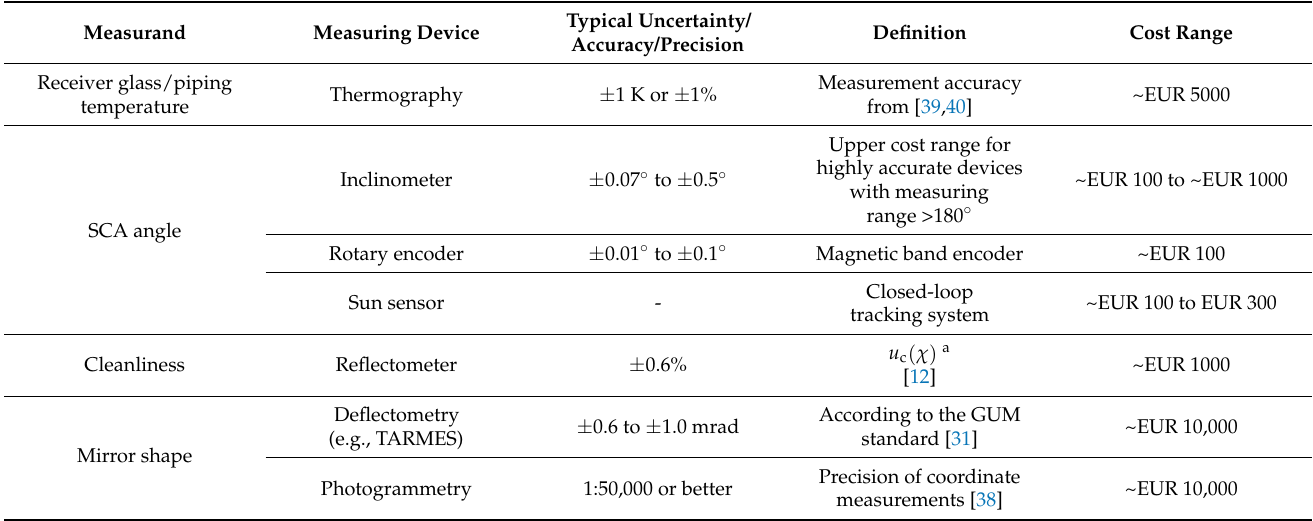
Table 2. Measurand, measuring device, measuring uncertainty and approximate cost range for specific measurements for parabolic trough collector